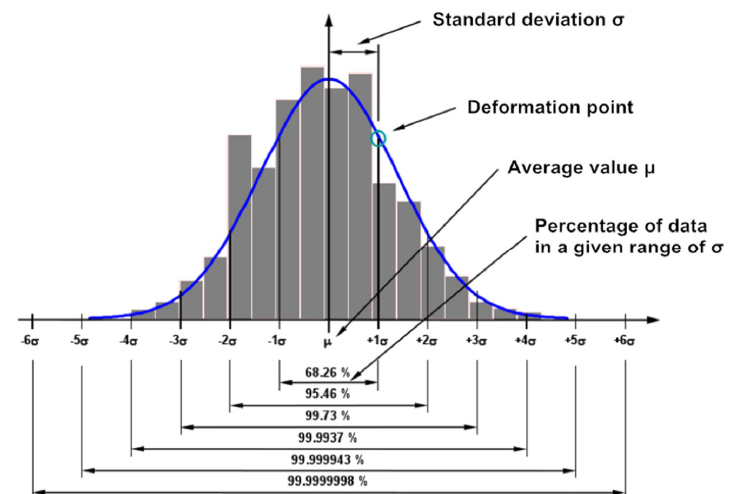
Figure 6. Schematic diagram of RSS variance analysis.